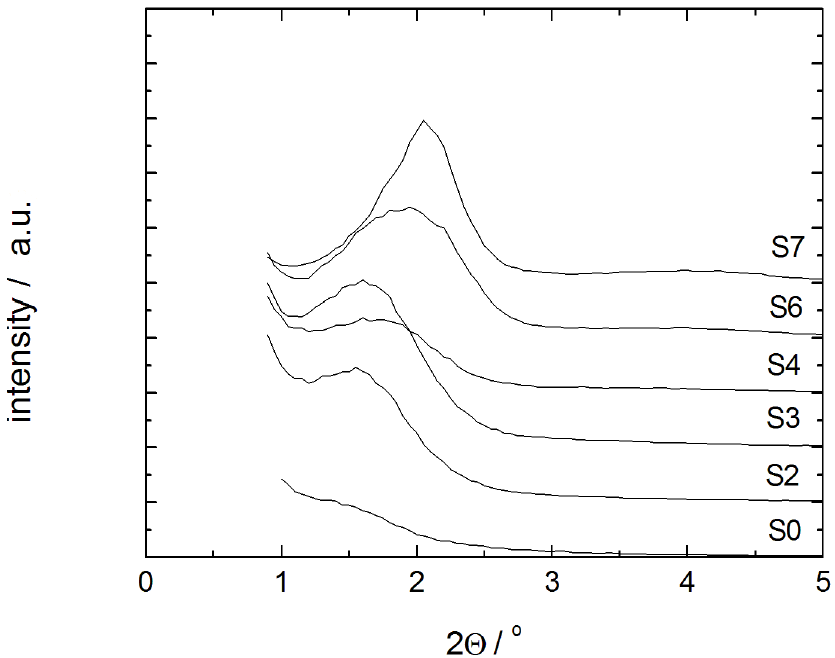
Figure 4. Powder XRD patterns of the initial silica gel S0 and the transformation products S2–S4, S6 and S7 (individual graphs are shifted by